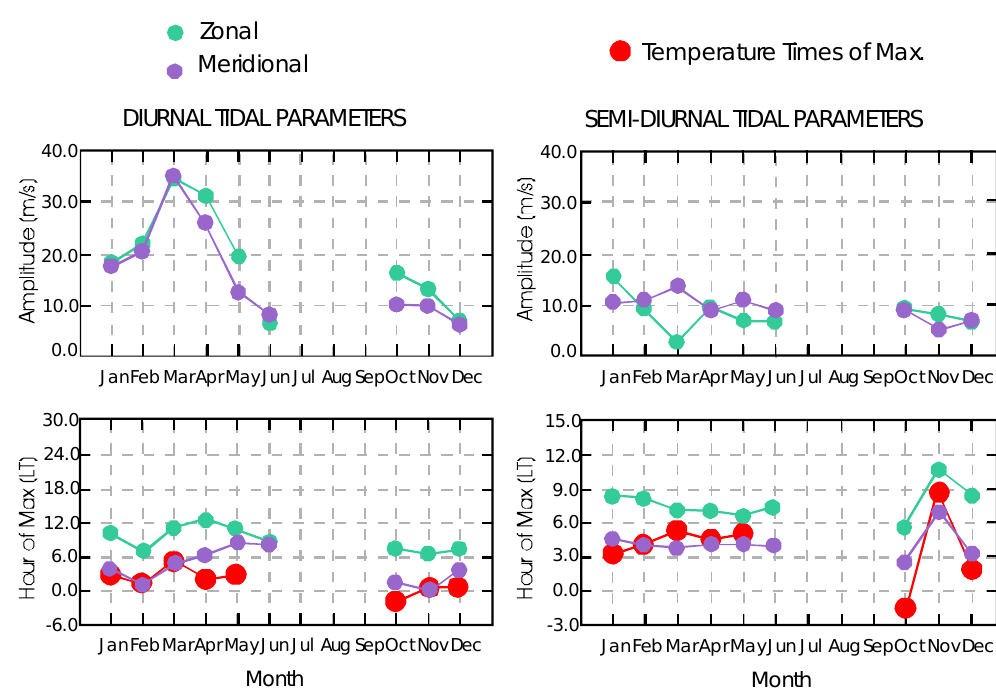
Fig.10 Fig. 10. Comparison between wind and temperature tidal phases (lower plots) for Albuquerque. The amplitudes of the wind tides are also shown for reference. In each case the errors are comparable to or smaller than the sizes of the